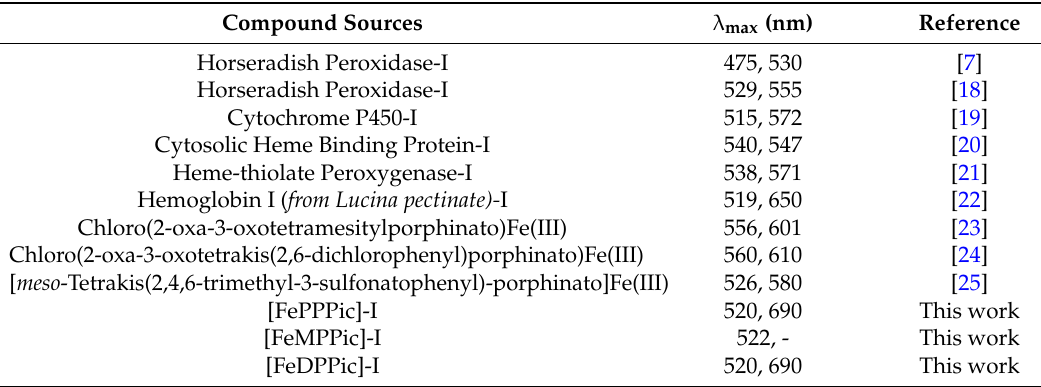
Table 1. Selected λ max from different sources of compound I.